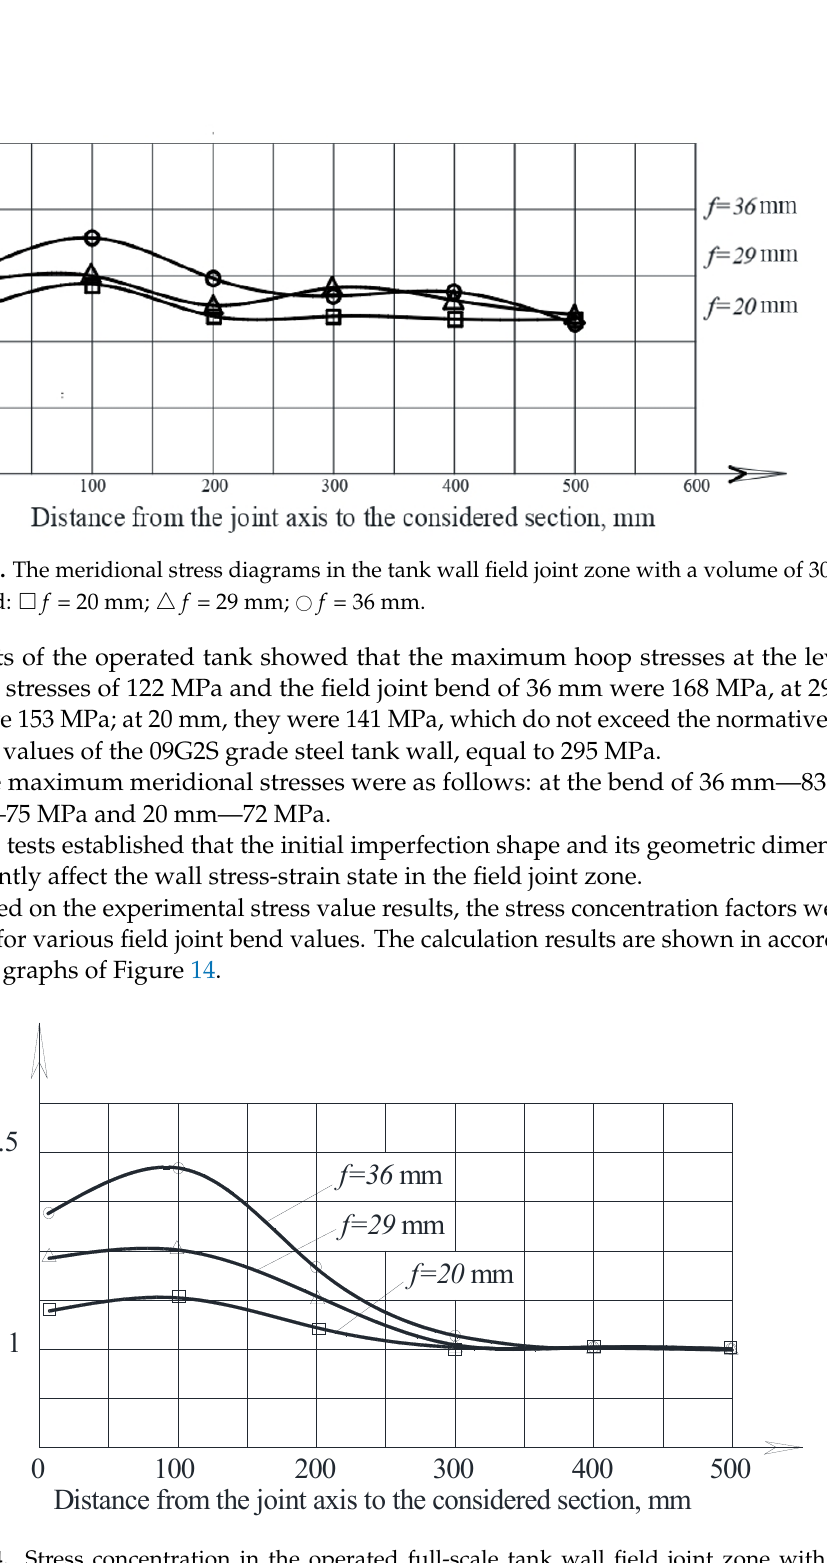
Figure 12. The hoop stress diagrams in the tank wall field joint zone with a volume of 3000 m 3 with bend: 我 f = 20 mm; 你 f = 29 mm; ○ f = 36mm.